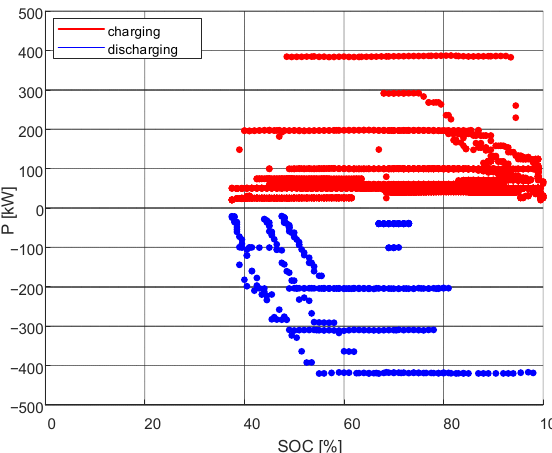
Figure 4. A set of points that forms the charging and discharging characteristics of the BESS for 1 min samples.